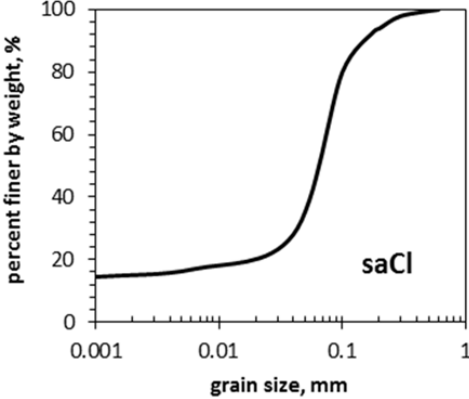
Figure 2. Particle size distribution of the tested soil.